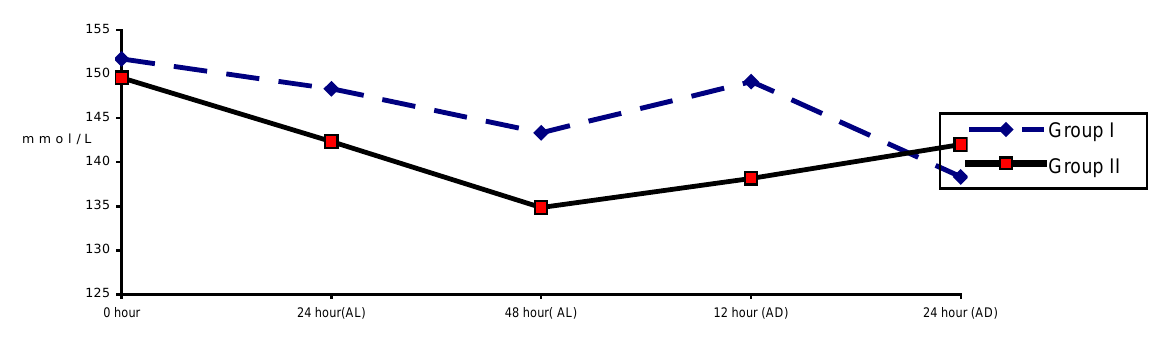
FIGURE 4. (SERUM SODIUM): Showing the Blood Glucose level (mmol/L) at different time interval. AL = after ligation, AD = after dialysis.